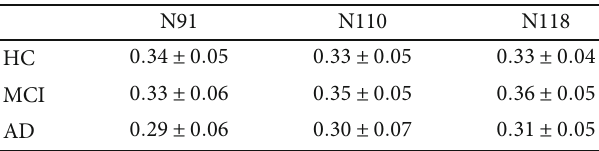
Table 5: Clustering coe ffi cient ( mean ± standard ) of the nodes that can signi fi cantly di ff erentiate HC, MCI, and AD groups. The edge weights were estimated with